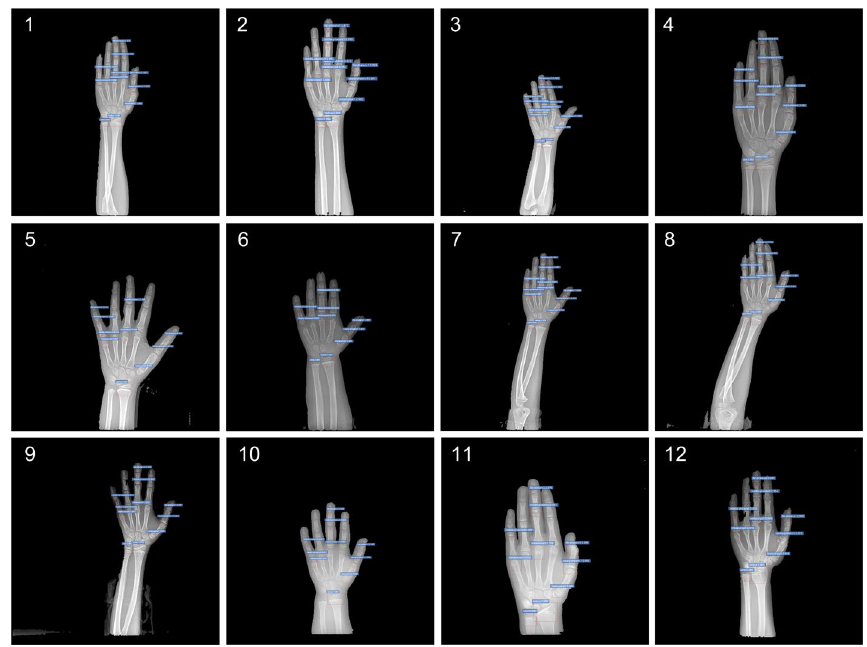
Fig. 12 Example outputs of ROIs detection in hand bone with faster RCNN. The labels of the bounding box, ROI name and AP are shown in the